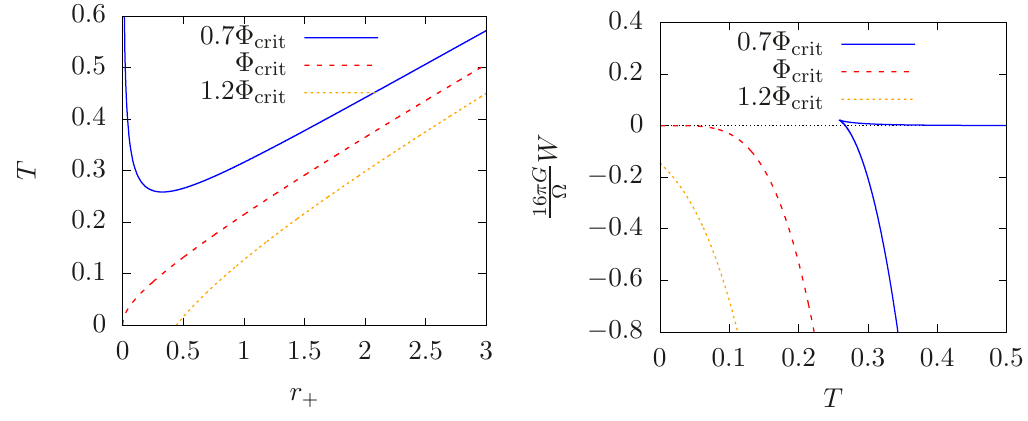
Figure 5 . Plots of T vs. r + (left) and W vs. T for the case n = 0 : 6, (cid:23) = 0 : 3, L 2 = ‘ 2 = 2, and D = 4. For these values, the critical potential is (cid:8) c = 0 :